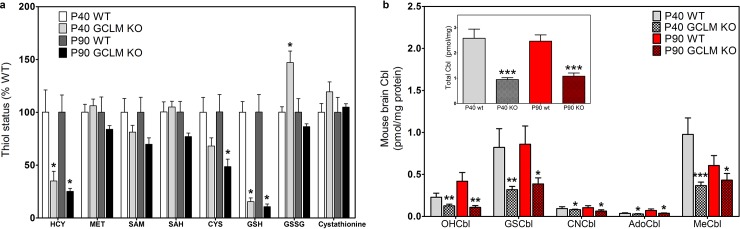
Redox and methylation metabolite and cobalamin status in GCLM KO mice.(a) Redox and methylation metabolite levels in frontal cortex of GCLM KO mice at P40 and P90 (n = 7). Results are expressed as a percentage of the WT level of each metabolite. (b) Levels of five individual Cbl species in frontal cortex of GLCM KO and WT mice at P40 and P90. Inset indicates total Cbl levels. * Indicates a significant difference from control group (* p < 0.05, ** p < 0.01, *** p < 0.001).